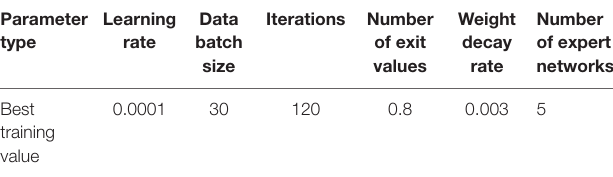
TABLE 5 | Optimal setting